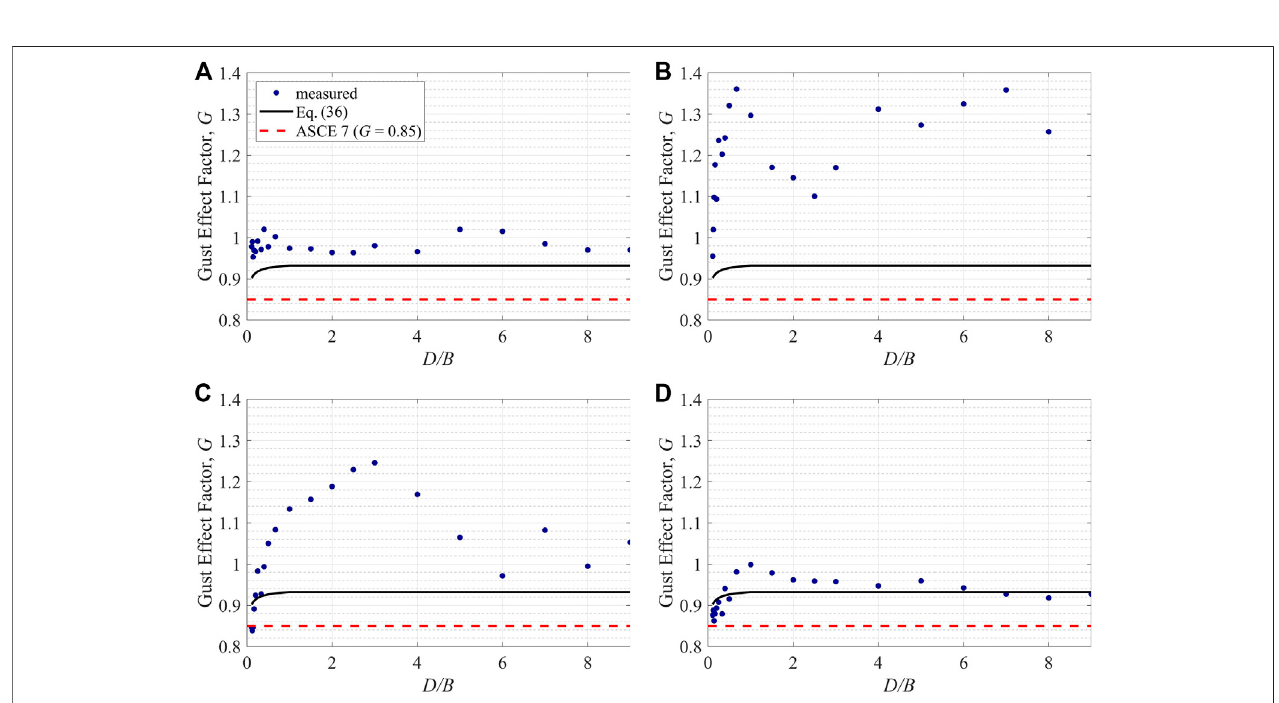
FIGURE 4 | Gust effect factors for area-averaged pressure coef fi cients on the (A) windward wall (B) side wall (C) leeward wall, and for (D) drag coef fi cients under the orthogonal wind directions.